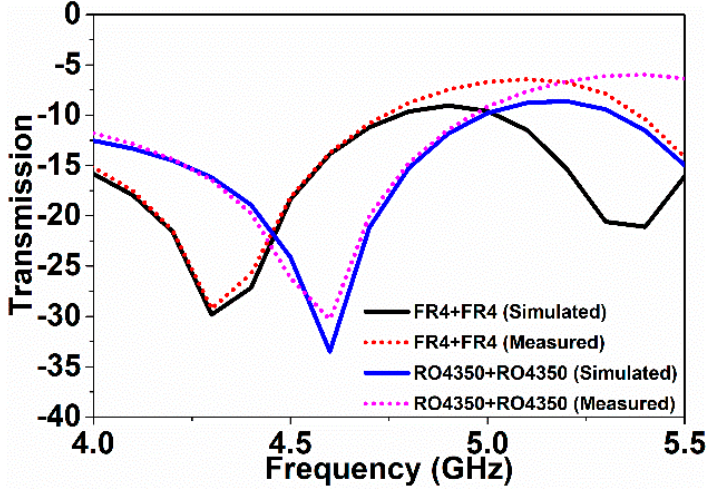
Figure 10. Transmission variances with FR4 and Rogers RO4350 double over-layers. The resonance moved downward when the thickness of the over-layer increased. Hence, for the Rogers RO4350 + Rogers RO4350 and FR4 + FR4 double over-layers, the resonances moved to 4.6 GHz and 4.3 GHz, respectively. Considering the frequency shift as a function of over-layer thickness, the sensitivity of the metamaterial sensor was 468 MHz/mm for the double over-layer. For a further extension of the experiment, multiple over-layers were considered. In this